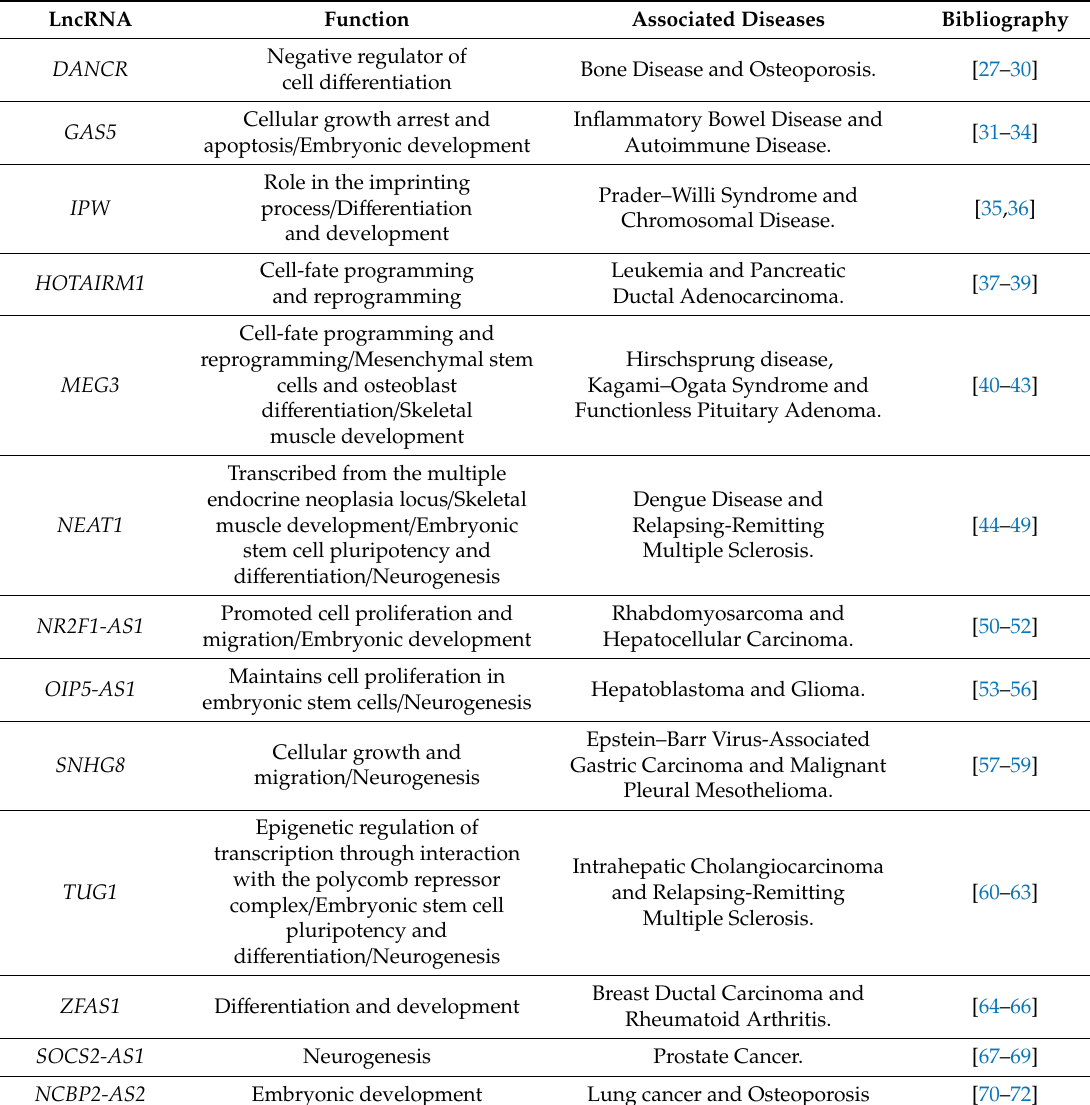
Table 1. LncRNAs identified in human